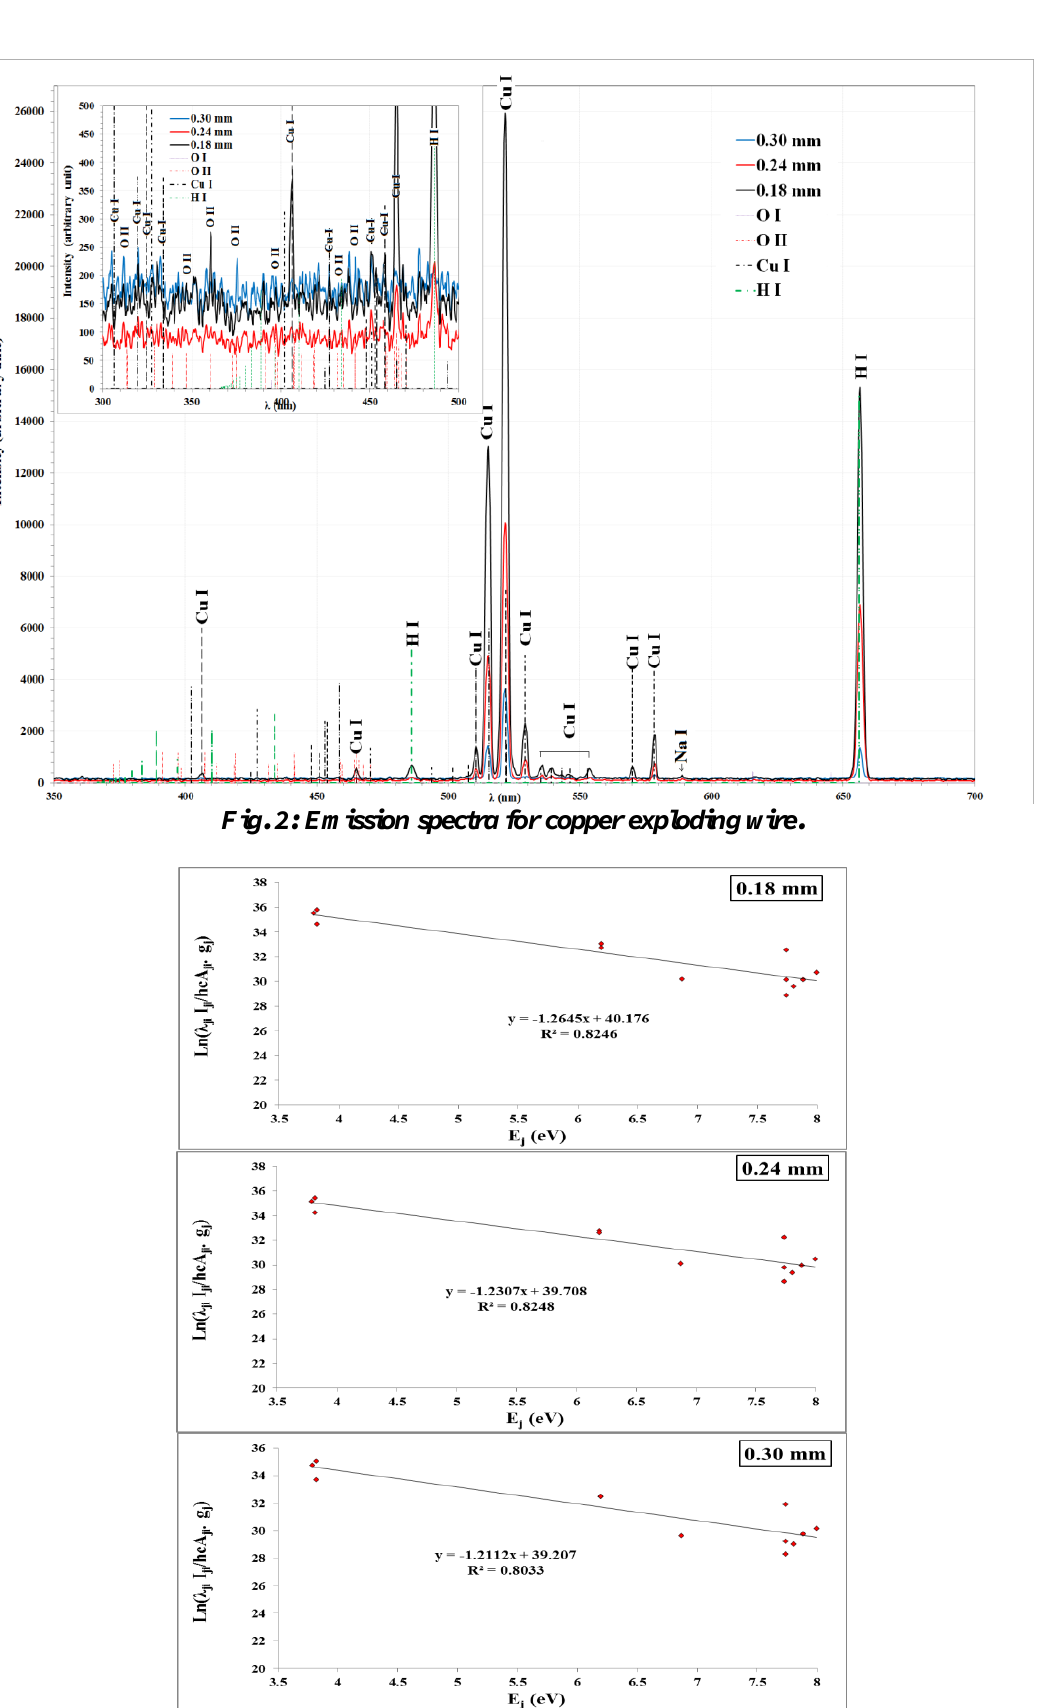
Fig. 3: Boltzmann plot from the Cu I lines produced by exploding wire with different diameters in distilled water and the current of 75